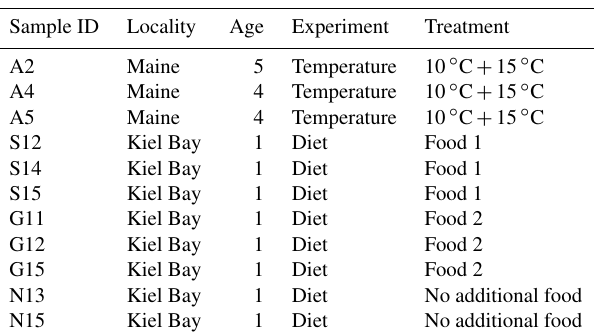
Table 1. List of the studied specimens of Arctica islandica and ex- perimental